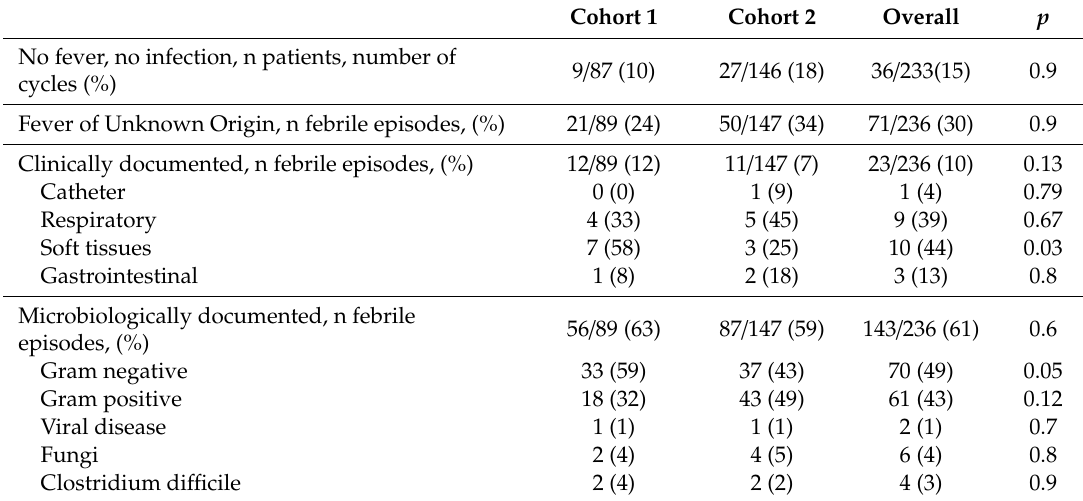
Table 3. Types of Infections and univariate comparison between